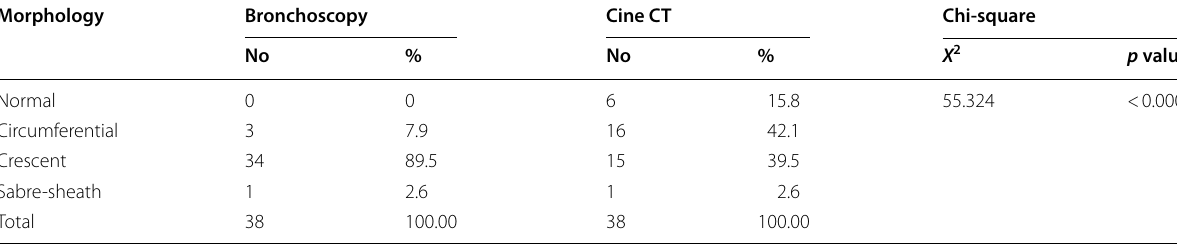
Table 2 Results of morphological classification of both bronchoscopy and cine